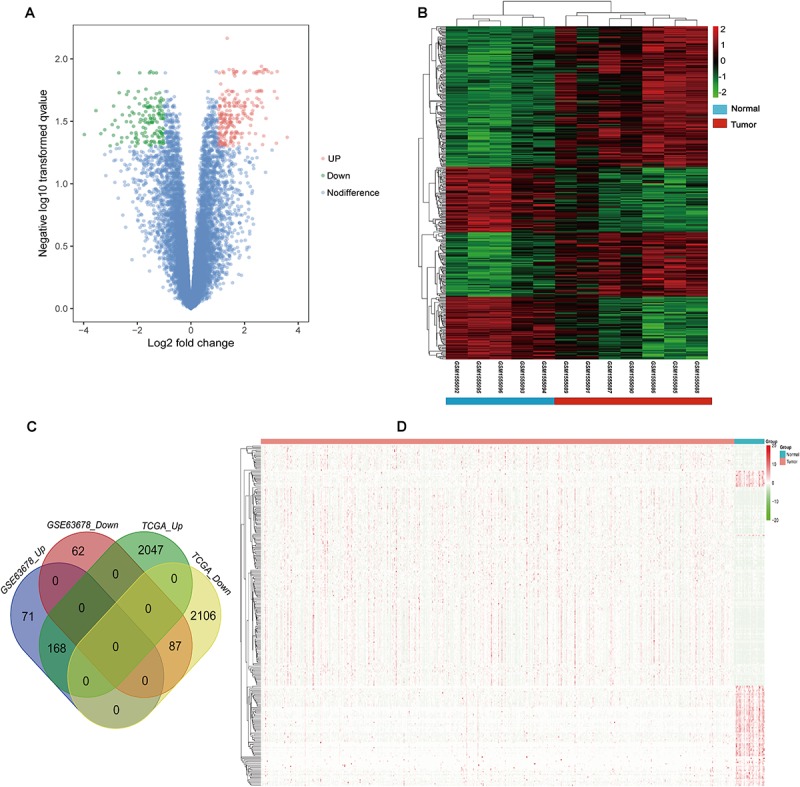
Identification of the DEGs. (A) Volcano plot of GSE63678. Red nodes represent DEGs with logFC >1 and p-value of <0.05. Green nodes represent DEGs with logFC <–1 and p-value of <0.05. (B) A heat map of all DEGs of GSE63678. Each column represents a sample and each row represents one gene. The gradual color ranging from green to red represents the gene expression changing from downregulation to upregulation. (C) Venn diagrams of common DEGs of GSE63678 and TCGA endometrial cancer (EC) dataset. 71 and 2,047 represent the upregulated DEGs of GSE63678 and TCGA EC dataset, respectively, while 62 and 2,106 represent the downregulated DEGs of GSE63678 and TCGA EC dataset, respectively. 168 represent common upregulated DEGs of GSE63678 and TCGA EC dataset, while 87 represent common downregulated DEGs of GSE63678 and TCGA EC dataset. (D) A heat map of the common DEGs in TCGA EC dataset. DEGs, differentially expressed genes; EC, endometrial cancer; TCGA, The Cancer Genome Atlas.